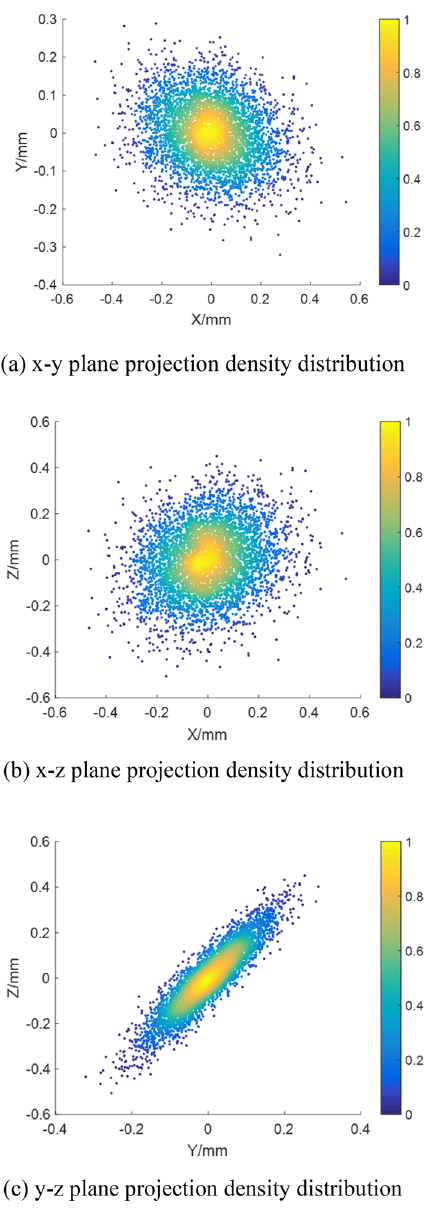
Figure 6. Error of three-dimensional spatial distribution and plane projection density distribution. ( a ) x–y plane projection density distribution, ( b ) x–z plane projection density distribution, ( c ) y–z plane projection density distribution.